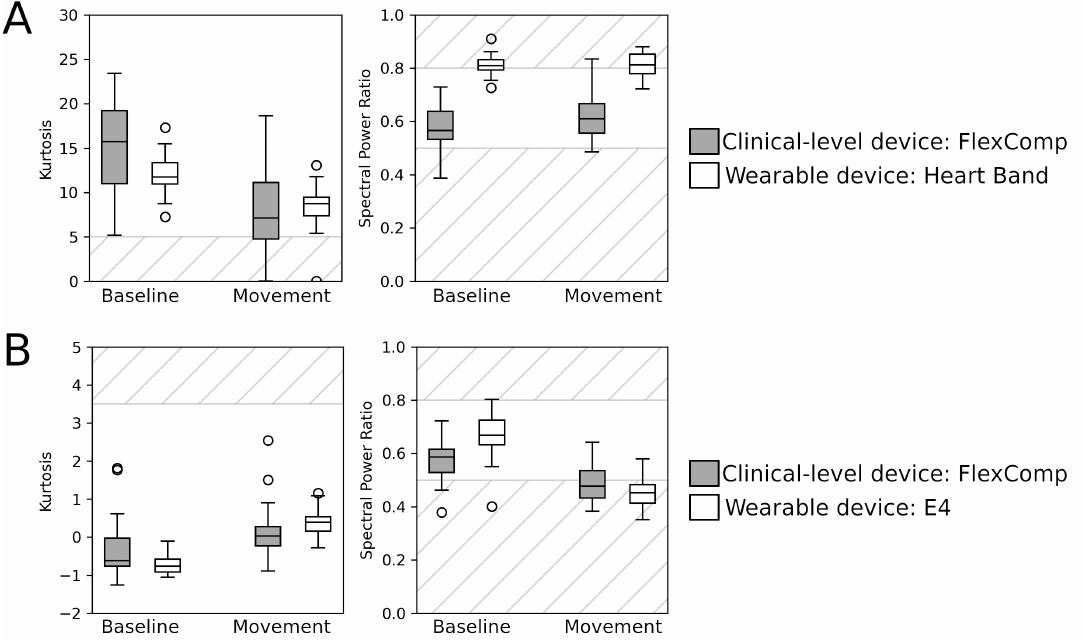
Figure 4. Signal quality indicators (SQIs) of the cardiac signals: ( A ). Kurtosis and spectral power ratio of the ECG collected from the FlexComp (gray) and Heart Band (white); ( B ). Kurtosis and spectral power ratio of the BVP collected from the FlexComp (gray) and E4 (white). Striped areas indicate the ranges of SQI values associated with low signal